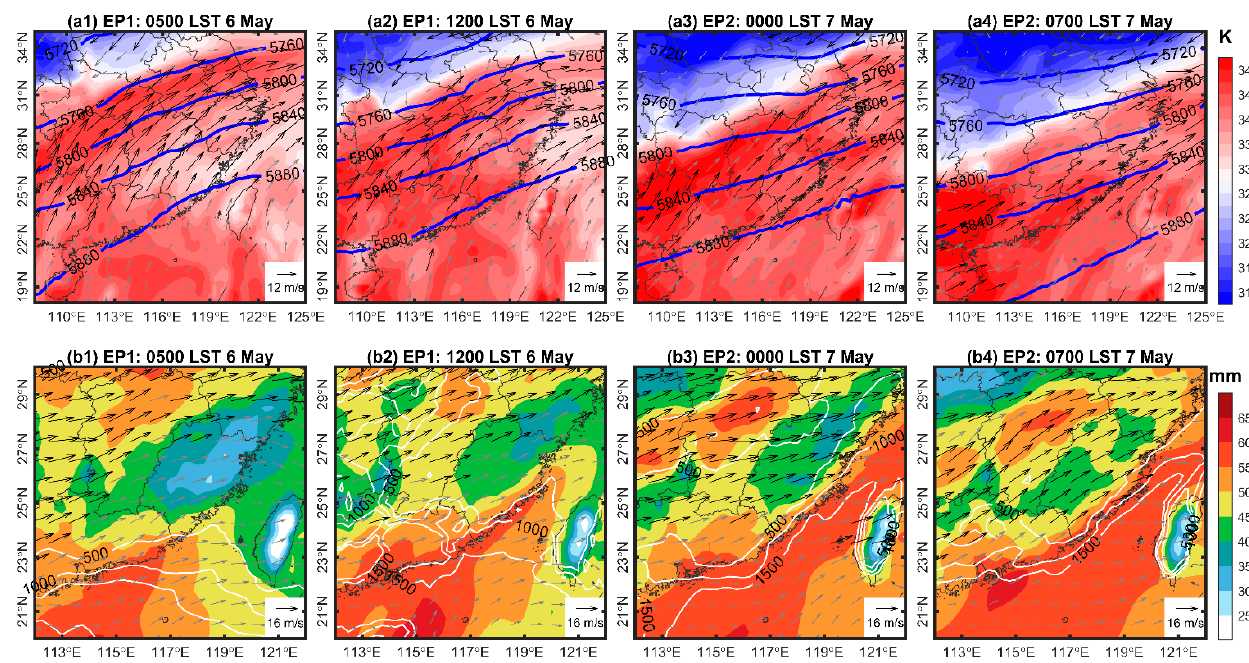
Figure 4. ERA5 reanalysis data at ( a1 , b1 ) 0500 and ( a2 , b2 ) 1200 LST 6 May 2018 during the former warm ‐ sector rainfall episode (EP1), and at ( a3 , b3 ) 0000 and ( a4 , b4 ) 0700 LST 7 May 2018 during the latter warm ‐ sector rainfall episode (EP2). Panels ( a1 – a4 ) show the geopotential height at 500 hPa (blue contour lines; units: gpm), equivalent potential temperature at 850 hPa (shading; units: K), and wind at 850 hPa (arrows; units: m s − 1 ; black arrows indicate wind speed no less than 12 m s − 1 and gray arrows indicate wind speed less than 12 m s − 1 ). Panels ( b1 – b4 ) show the convective available potential energy (CAPE) from 500 to 1500 J kg − 1 (white contour lines), precipitable water (shading; units: mm), and vertical wind shear of the 0–6 km AGL layer (arrows; units: m s − 1 ; black arrows indicate shear magnitude no less than 16 m s − 1 and gray arrows indicate shear magnitude less than 16 m s − 1 ). The provincial boundaries are denoted by gray curves.